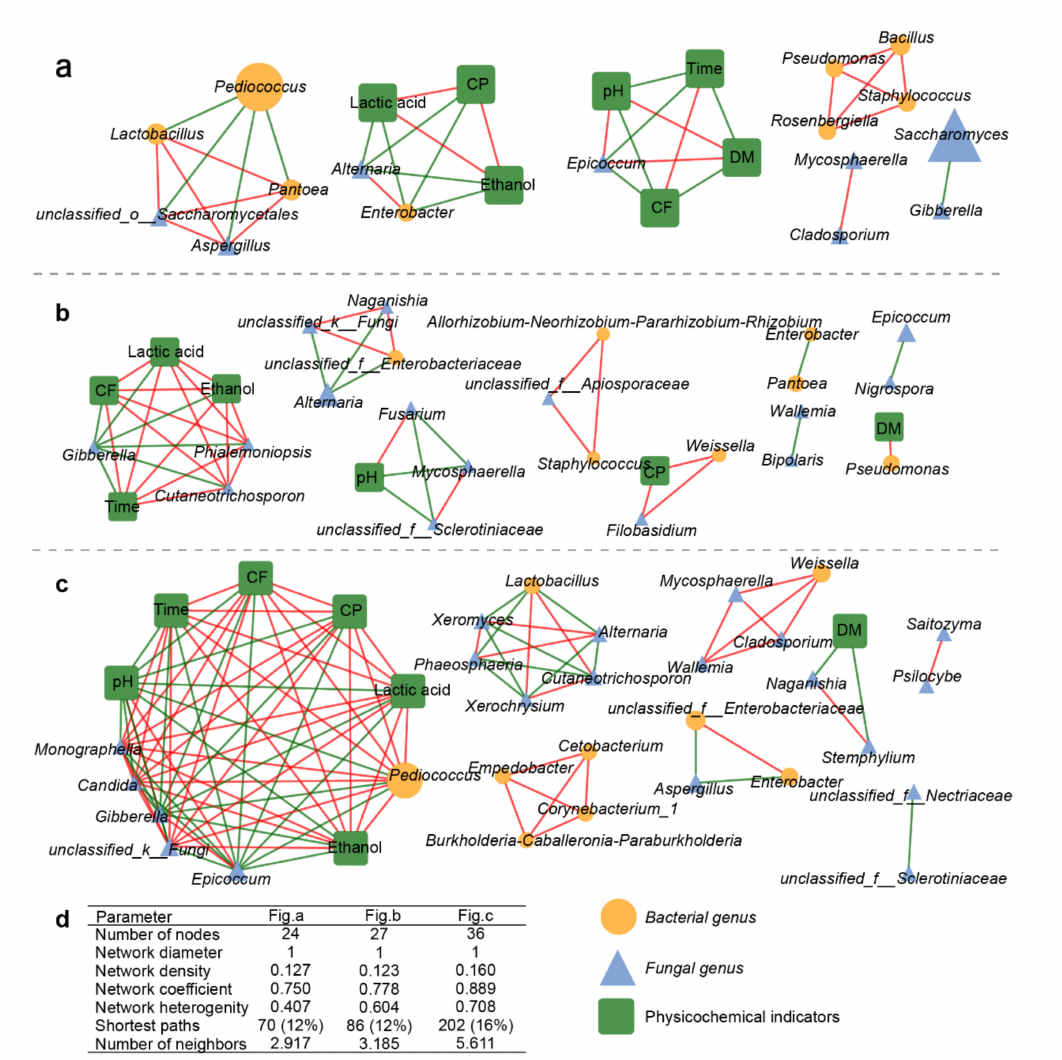
Figure 6. Network analysis showing co-occurrence and modular patterns based on the correlation among microbial communities and physicochemical indicators in response to exogenous probiotics ( a ), no treatment ( b ), and exogenous enzymes ( c ). Red edges: positive correlation; green edges: negative correlation; the size of nodes indicates the average relative abundance of the genera. ( d ) The topological parameters of networks. Time: fermented time; DM: dry matter; CF: crude fat; CP: crude